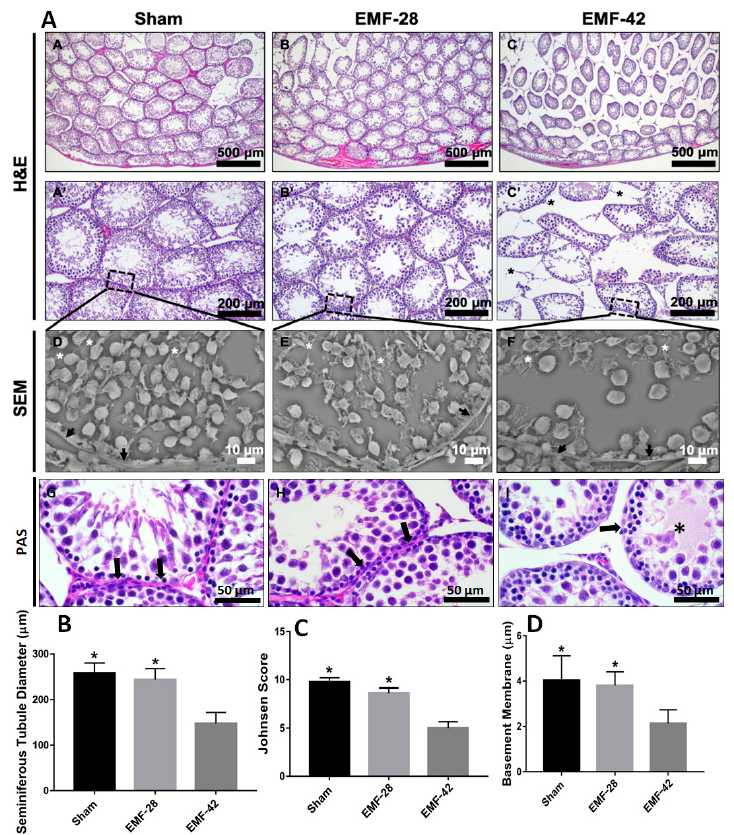
Figure 3. ( A ). Representative photomicrographs of rat testis sections. The top two lines, H&E- stained sections of groups (A-A’, Sham group; B-B’, EMF-28 group; C-C’, EMF-42 group). Third line, scanning electron micrograph (SEM) of testicular tissue of groups (D, Sham; E, EMF-28 group; F, EMF-42 group). Black asterisk, interstitial space between seminiferous tubules, white asterisk, late spermatids; black arrow, seminiferous tubule basement membrane. Bottom line, periodic acid-Schiff (PAS) stained sections in the testis of rats. A, Sham group ( n = 15); B, EMF-28 ( n = 10) group; C, EMF- 42 ( n = 10) group. Asterisk, cellular debris; black arrow, seminiferous tubule basement membrane. Scale bar, 50 µm. ( B , C ) Morphological parameters of Sham ( n = 15), EMF-28 ( n = 10), and EMF-42 ( n = 10) groups. * Significantly different from EMF-42 group ( p < 0.0001, one-way ANOVA with subse- quent LSD multiple comparisons test). ( D ) Seminiferous tubule basement membrane thickness. * Significantly different from EMF-42 group ( p < 0.0001, (one-way ANOVA with subsequent LSD multiple comparisons test). EMF: 50 Hz electromagnetic field exposure (4 h/day, 5 days/week for 7 (EMF-28) and 9 (EMF-42) weeks), Sham group was exposed to the same conditions as the EMF group, except for the EMF exposure.